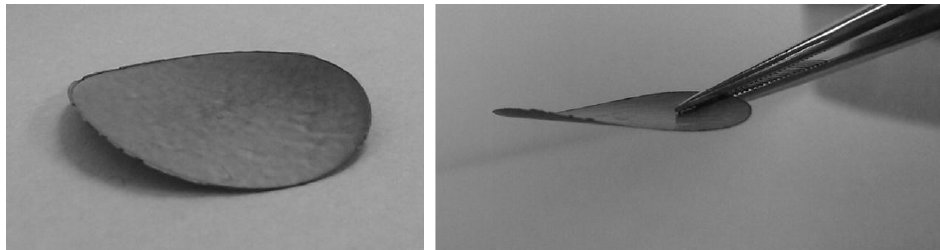
Figure 4. Freestanding reduced graphene oxide (rGO) films.